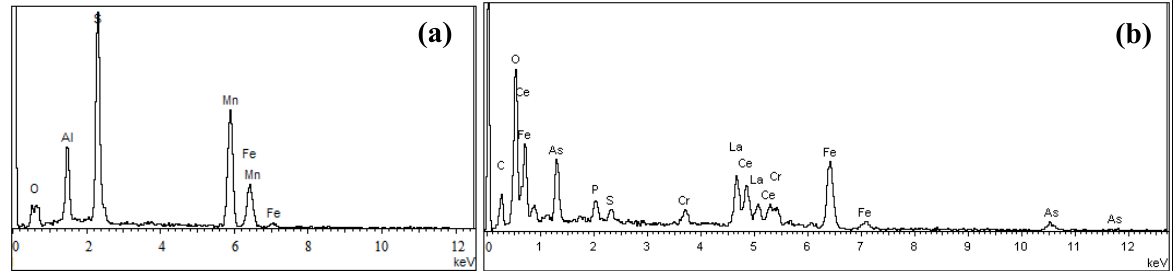
Figure 4. The back-scattered electron micrographs of the inclusions after REM addition ( a ) 1# ingot with 0% REM; ( b ) 2# ingot with 0.015% REM; ( c ) 3# ingot with 0.025% REM; ( d ) 4# ingot with 0.1% REM.